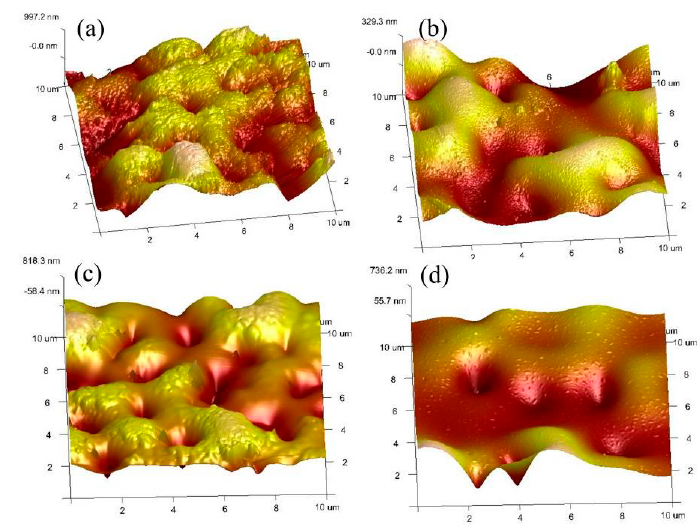
Figure 5. Atomic force microscopy (AFM) images of coatings with various BR contents: ( a ) UMAO; ( b ) UMAO/PLGA/BR1.5; ( c ) UMAO/PLGA/BR3.0; ( d ) UMAO/PLGA/BR6.0. Table 3. Roughness values of various coatings.